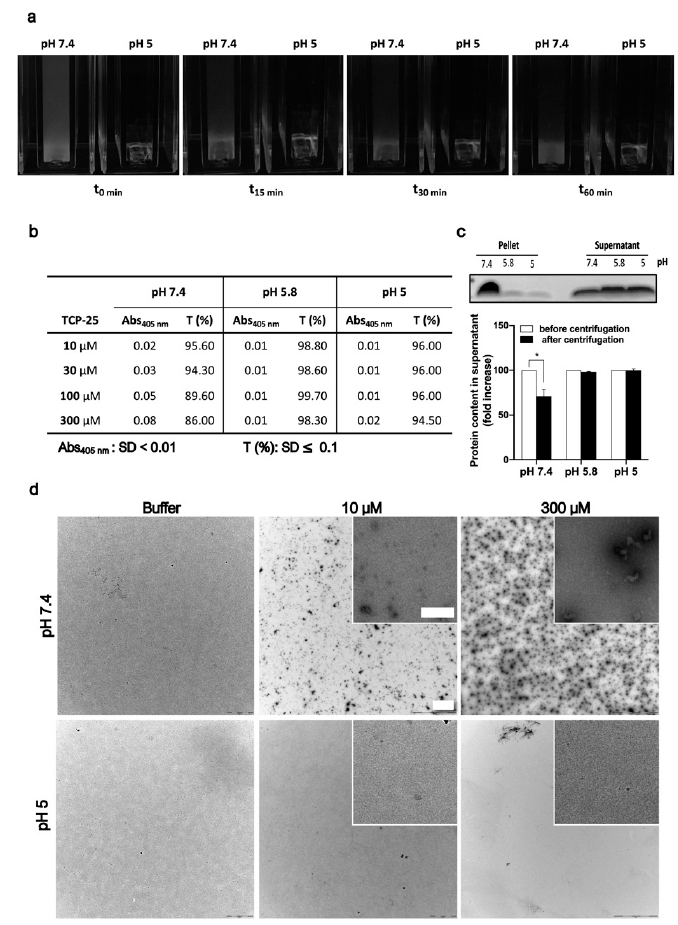
Figure 1. Effects of pH and concentration on TCP-25 oligomerization. ( a ) Representative pictures of cuvettes containing 300 µM TCP-25 dissolved in 10 mM Tris at pH 7.4 or 10 mM NaOAc at pH 5 immediately after storage at 4 °C (t 0 min) and indicated time points after incubation at RT. ( b ) Absorbance and transmittance values at 405 nm for 10-300 µM TCP-25 dissolved in 10 mM Tris at pH 7.4 or in 10 mM NaOAc at pH 5.8 and 5. ( c ) SDS-PAGE analysis of pellets and supernatants from the centrifugation of 300 µM TCP-25 dissolved in 10 mM Tris at pH 7.4 or in 10 mM NaOAc at pH 5.8 or 5.0. The graph shows the TCP-25 concentration ± SD after centrifugation. ( d ) TEM images illustrating that oligomerization is pH and concentration dependent. TCP-25 was dissolved in pH 7.4 and 5.0 buffers at the indicated concentrations and analyzed by TEM. Scale bar in the 40× and 100× (insert) magnification window represents 2.5 and 0.25 µm, respectively. All experiments were performed 3 times ( n = 3), and * indicates p < 0.05. p value was determined using one-way ANOVA with Dunnett’s multiple comparison test.